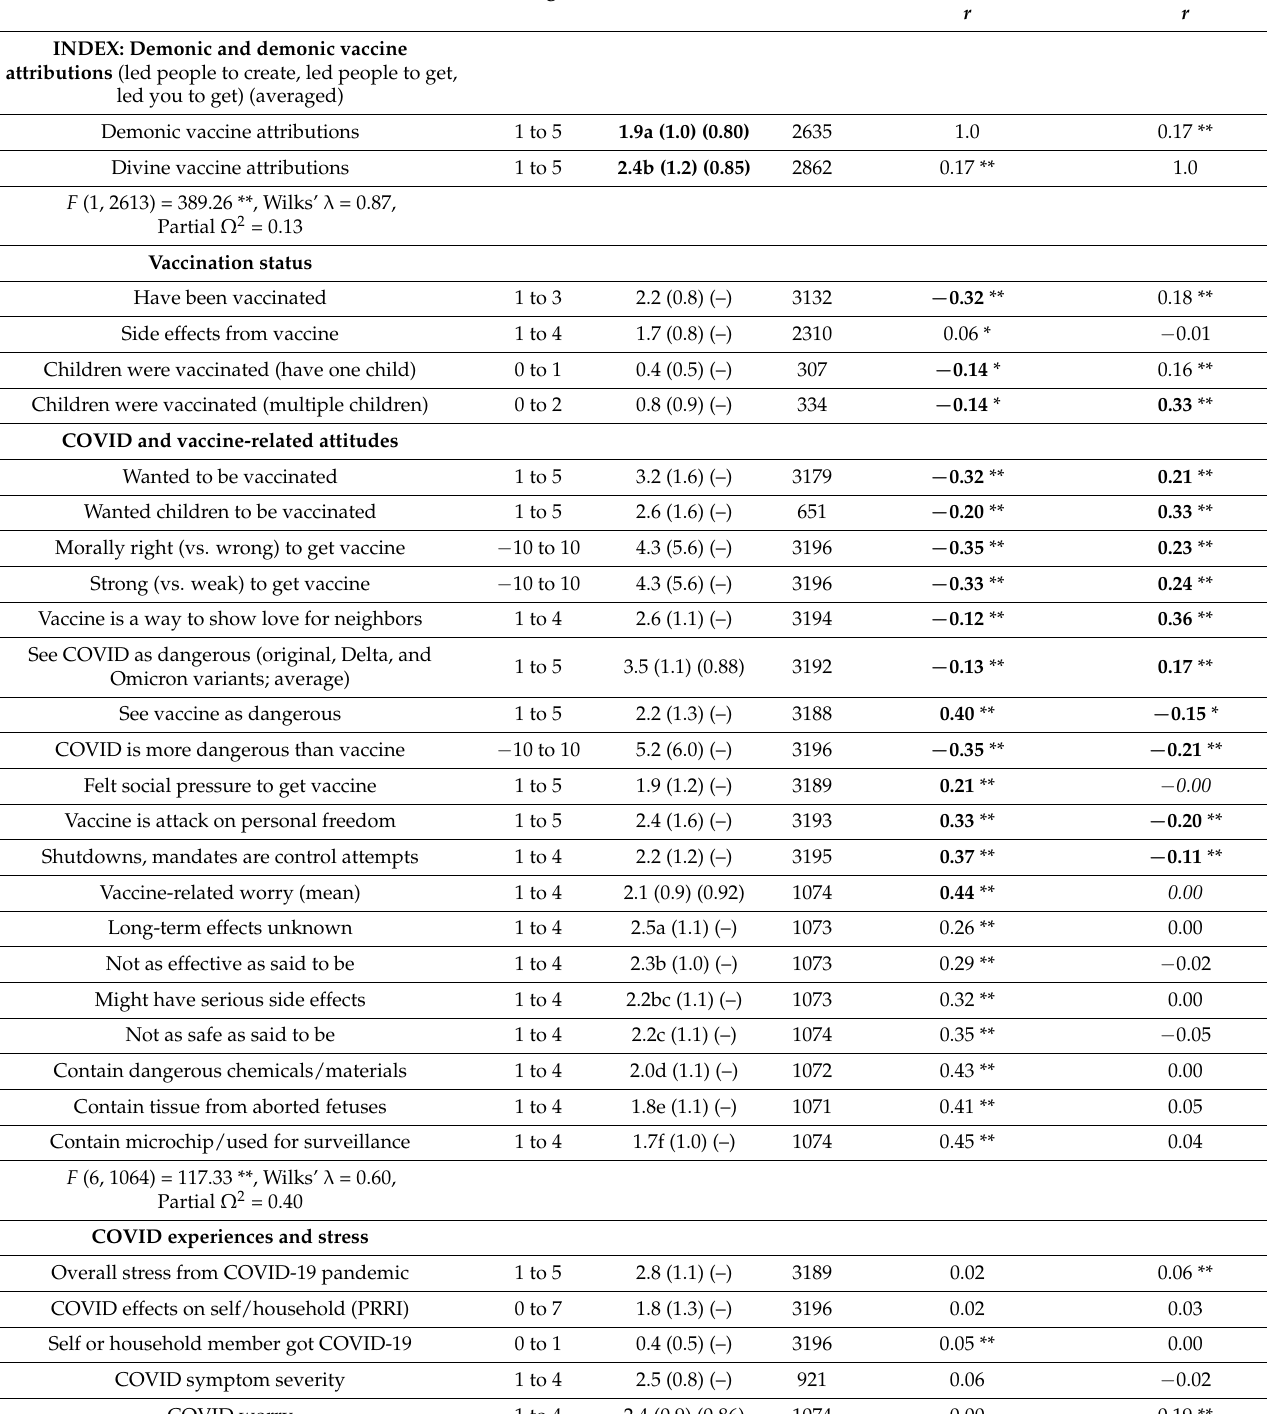
Demonic Vaccine Attributions